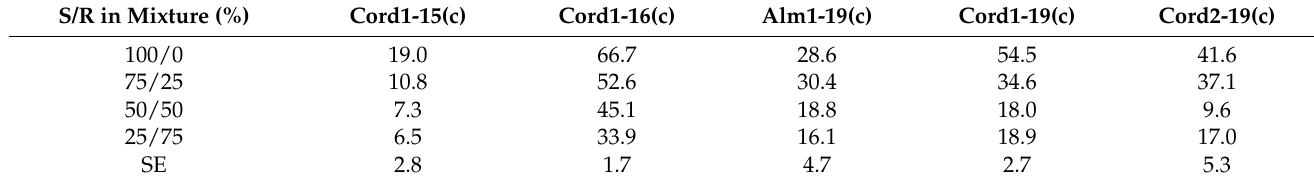
trials carried out (S/R: proportions of susceptible cultivar Messire and resistant cultivar Eritreo; SE: standard error).